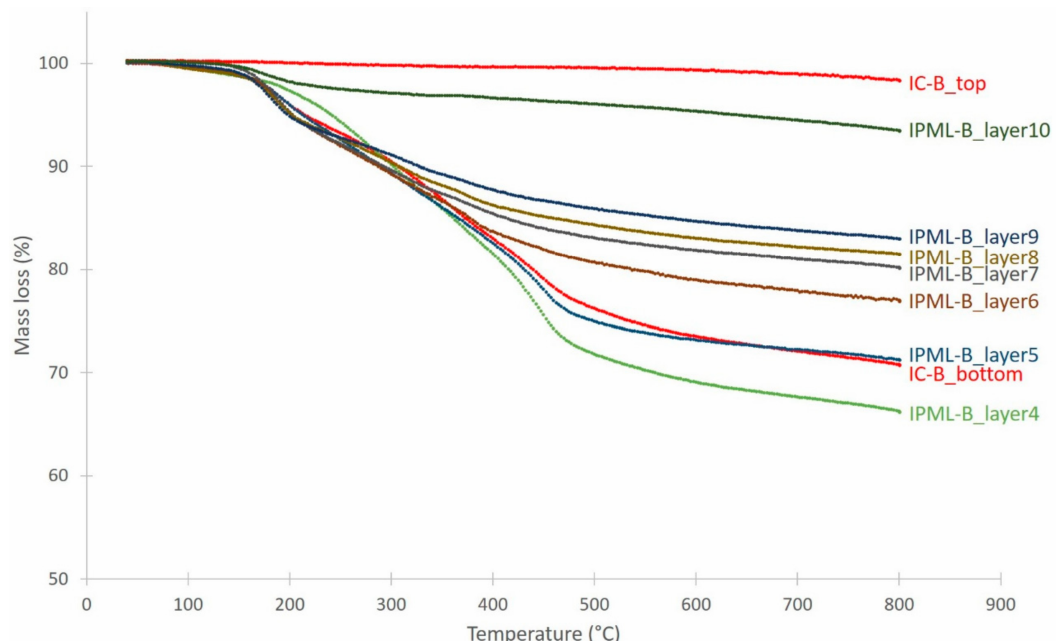
Figure 13. TG curves for each char layer of IPML-B and for IC-B char layer, obtained after 15 min burn-through test exposure.